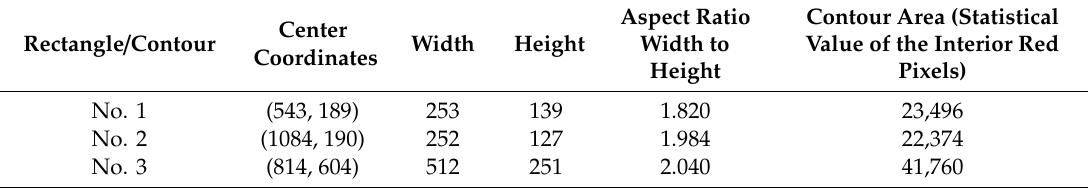
Figure 7. The contours of the projected image ( a ) and the image captured ( b ) in the experiment. Table 1. Parameters of contours in Figure 7a (unit / pixel).